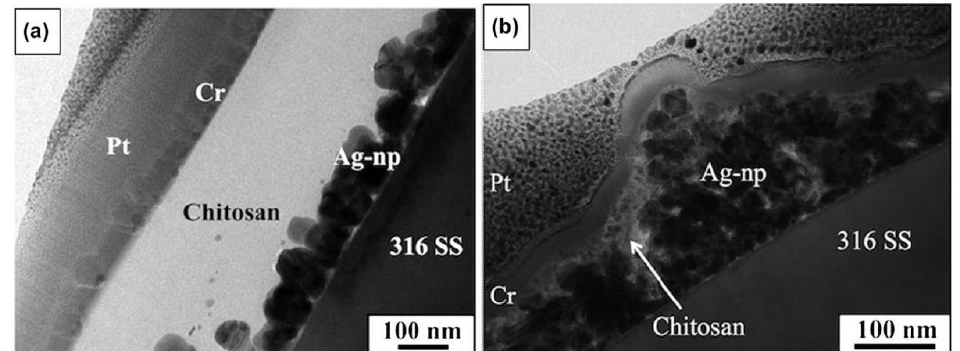
Figure 7. TEM cross-sections of ( a ) CS/Ag and ( b ) CS/Bioglass (BG)/Ag films (adapted with permission from reference [18]).